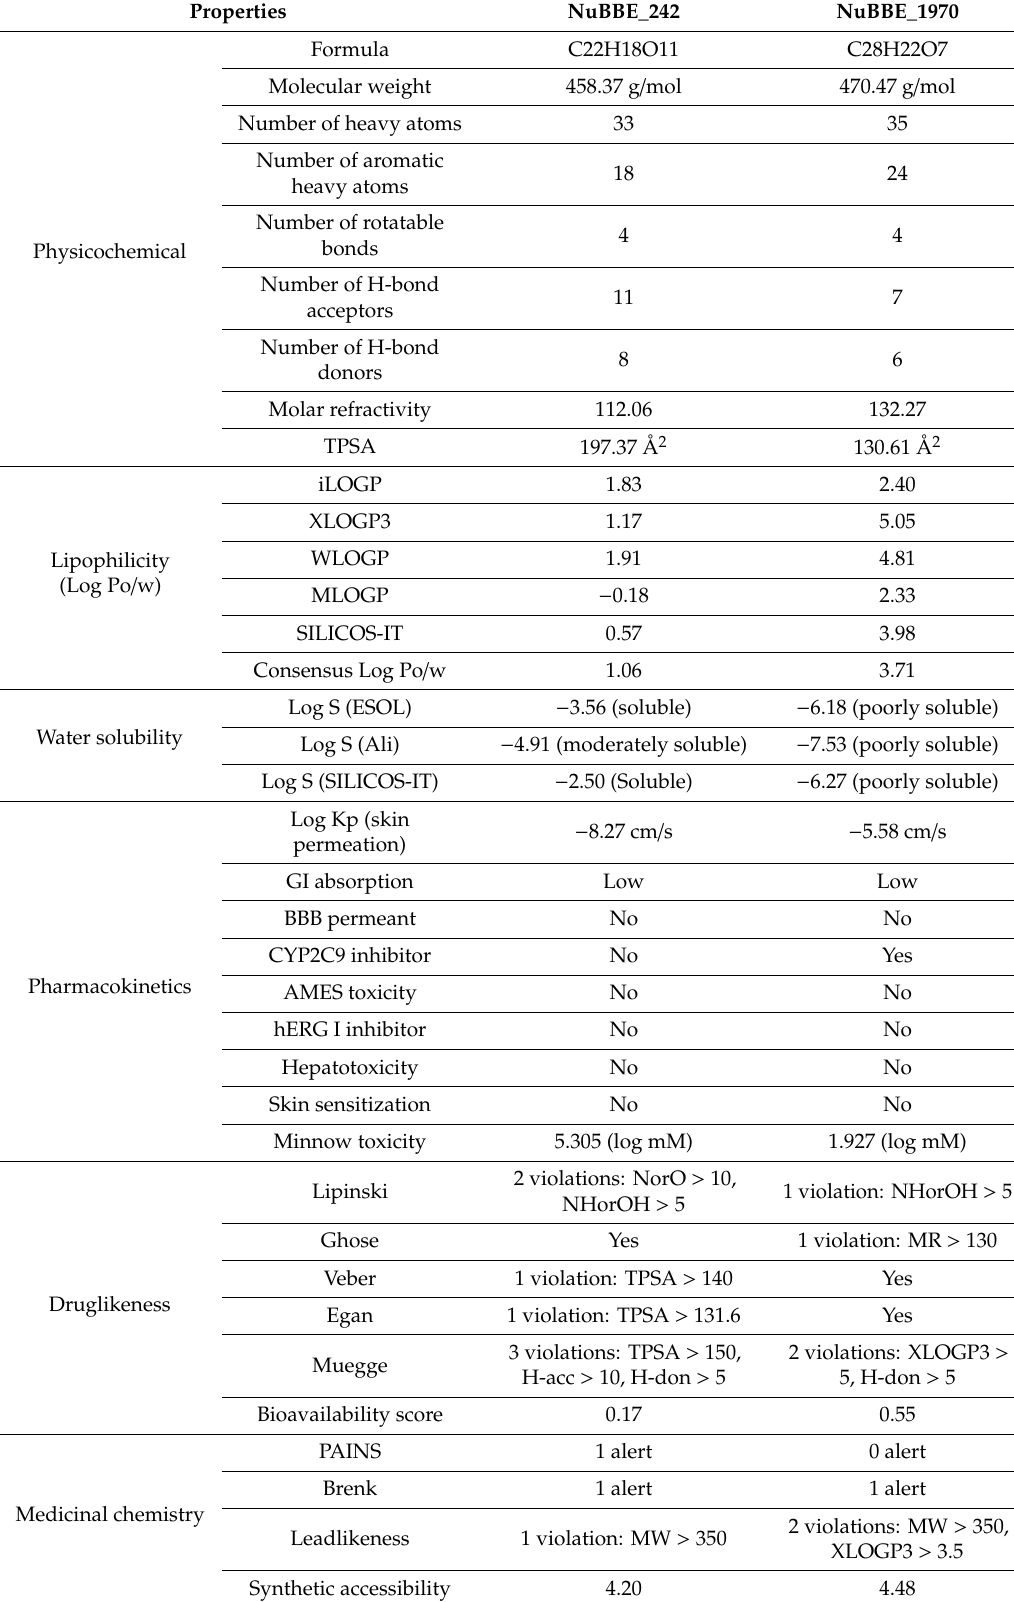
Table 3. Pharmacokinetic properties of NuBBE-1970 and